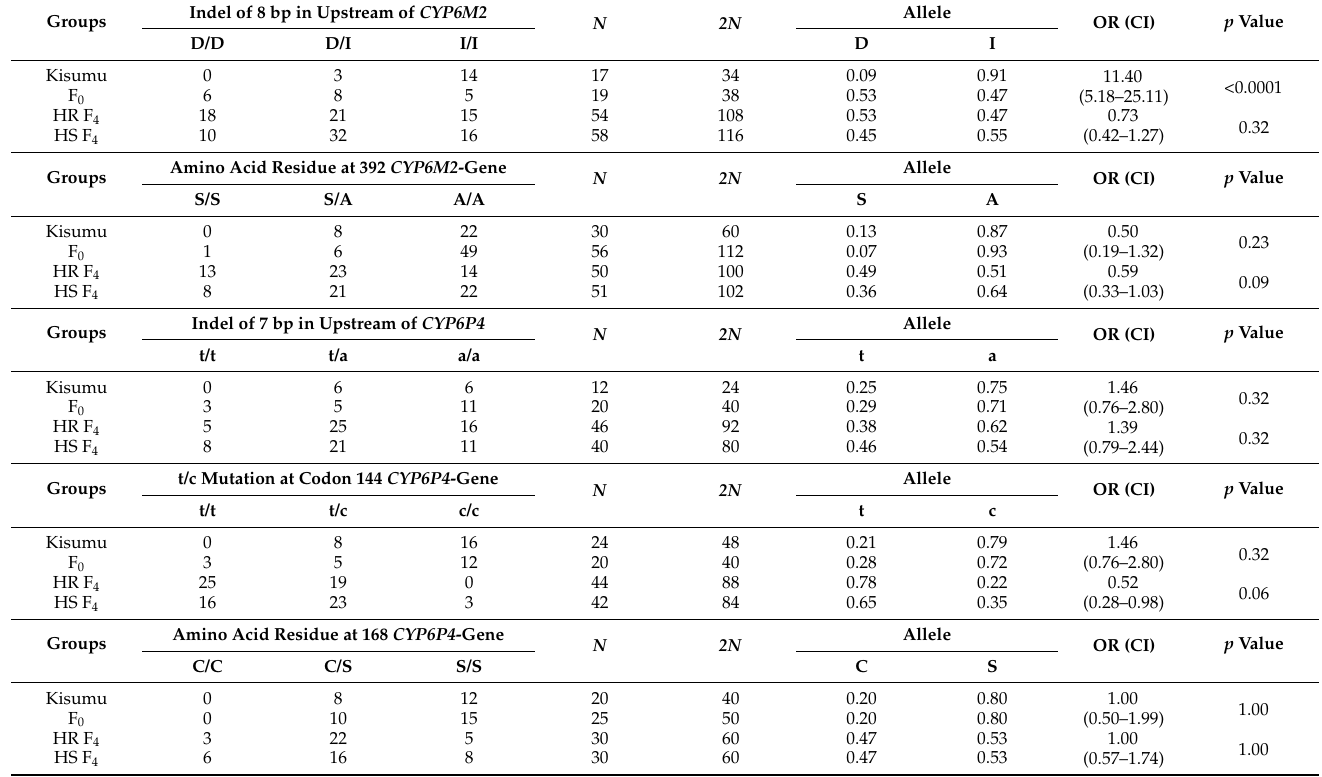
tion GCG- > GCA in codon 115 was linked to the mutation of TGC- > AGC in codon 168, Table 5. Frequencies of key mutations found in CYP6M2 and CYP6P4 in An. gambiae which led to an amino acid change of cysteine to serine ( C168S ) substitution; the two mu-